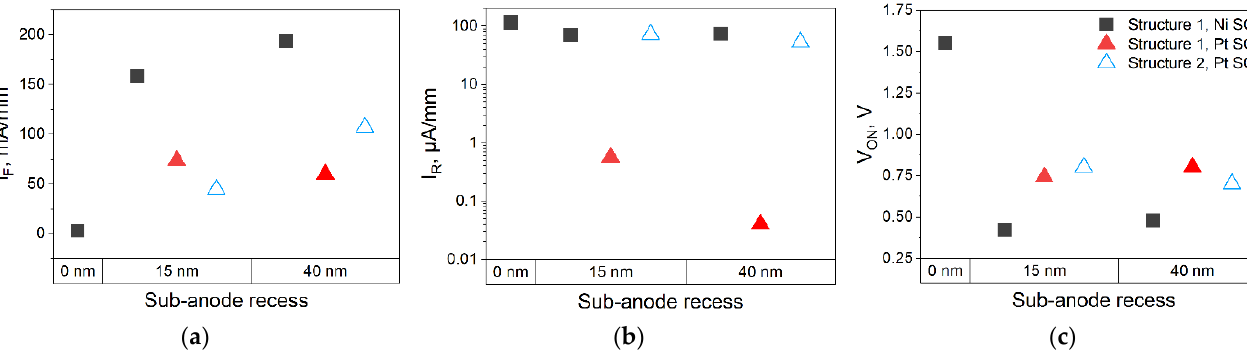
Figure 5. Influence of subanode recess on electrical parameters of SBDs with different SC and structures: ( a ) Influence of recess depth on I F ; ( b ) Influence of recess depth on I R ; ( c ) Influence of recess depth on V ON .